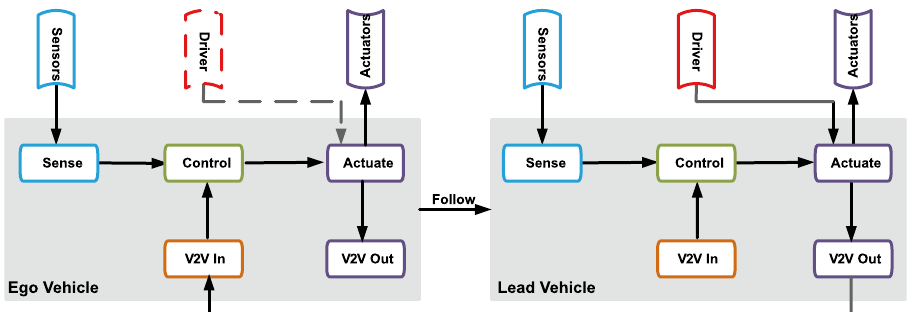
Fig. 3 Cooperative automated vehicle functional